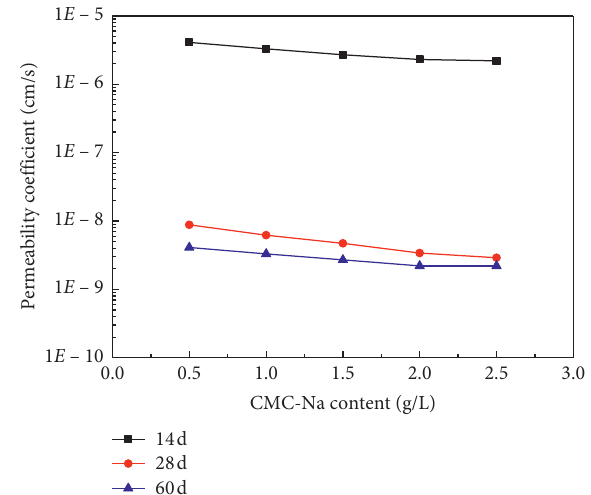
Figure 7: Curve of influence of different CMC-Na contents on permeability coefficient of